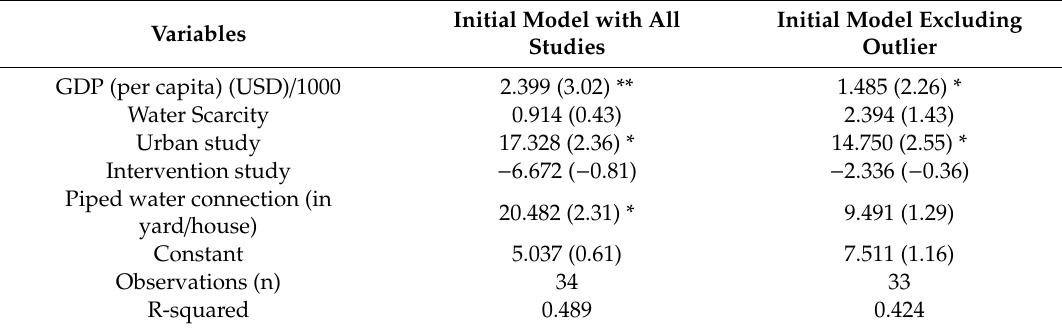
Table A4. Initial multiple linear regression models, including identified outlier [50] and excluding the outlier, of reported LPCD across Africa, based on a subset of studies published between 2000 and 2019.